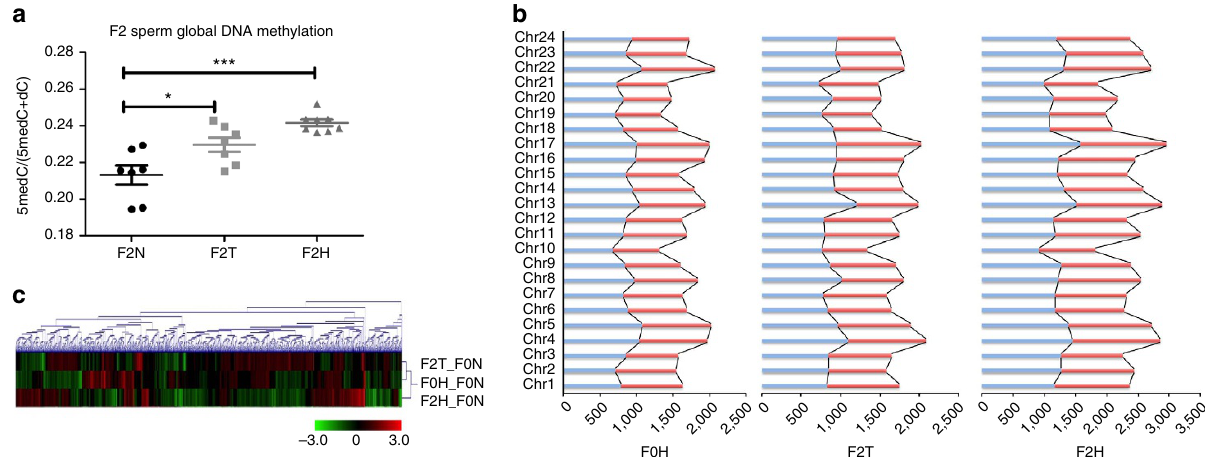
Figure 4 | Transgenerational effect of hypoxia on the epigenome. ( a ) The ratio of 5-methylcytosine to the total cytosine pool was measured in the F2N, F2T and F2H groups using liquid chromatography-tandem mass spectrometry (LC-MS/MS; n ¼ 7–8). ( b ) Clustering of differentially methylated regions (DMRs) in the F0H, F2Tand F2H groups compared to the F0N groups. Hypermethylated and hypomethylated regions are represented by red and green colour, respectively ( n ¼ 10). ( c ) Chromosomal distribution of DMRs normalized to the F0N group. Red and blue bars indicate the numbers of hypermethylated regions and hypomethylated regions, respectively. Data are presented as the means ± s.e.m. (* P o 0.05, *** P o 0.001; n ¼ affects global DNA methylation in sperm cells (Fig. 4a). DNA followed by massively parallel sequencing (MeDIP-seq) was hypermethylation was found in sperm of both the F2T and F2H performed to elucidate specific epigenetic alterations in the sperm groups ( n ¼ 7–8), suggesting that sperm epigenetic changes DNA methylome that can be transferred to the F2 generation. induced by hypoxia can be inherited by fish of the F2T group that Approximately 50 million paired-end reads containing 3.8 Gb of have never been exposed to hypoxia. This finding also correlated raw data were obtained for each of the transgenerational, hypoxic well with the increase in H3K9me2 in the F2T group described and normoxic groups in F0 and F2. The distribution of the dif- above (Fig. 3d). However, the global DNA methylation changes in ferentially methylated regions at the chromosomal level (Fig. 4b) F2T and F2H only provided a limited understanding of the was similar for all three groups (F0H, F2T and F2H), and a molecular mechanisms underpinning the observed transgenera- similar pattern was also found among the three groups in terms of tional effects. Hence, methylated DNA immunoprecipitation the types of methylated genomic elements (including intergenic,